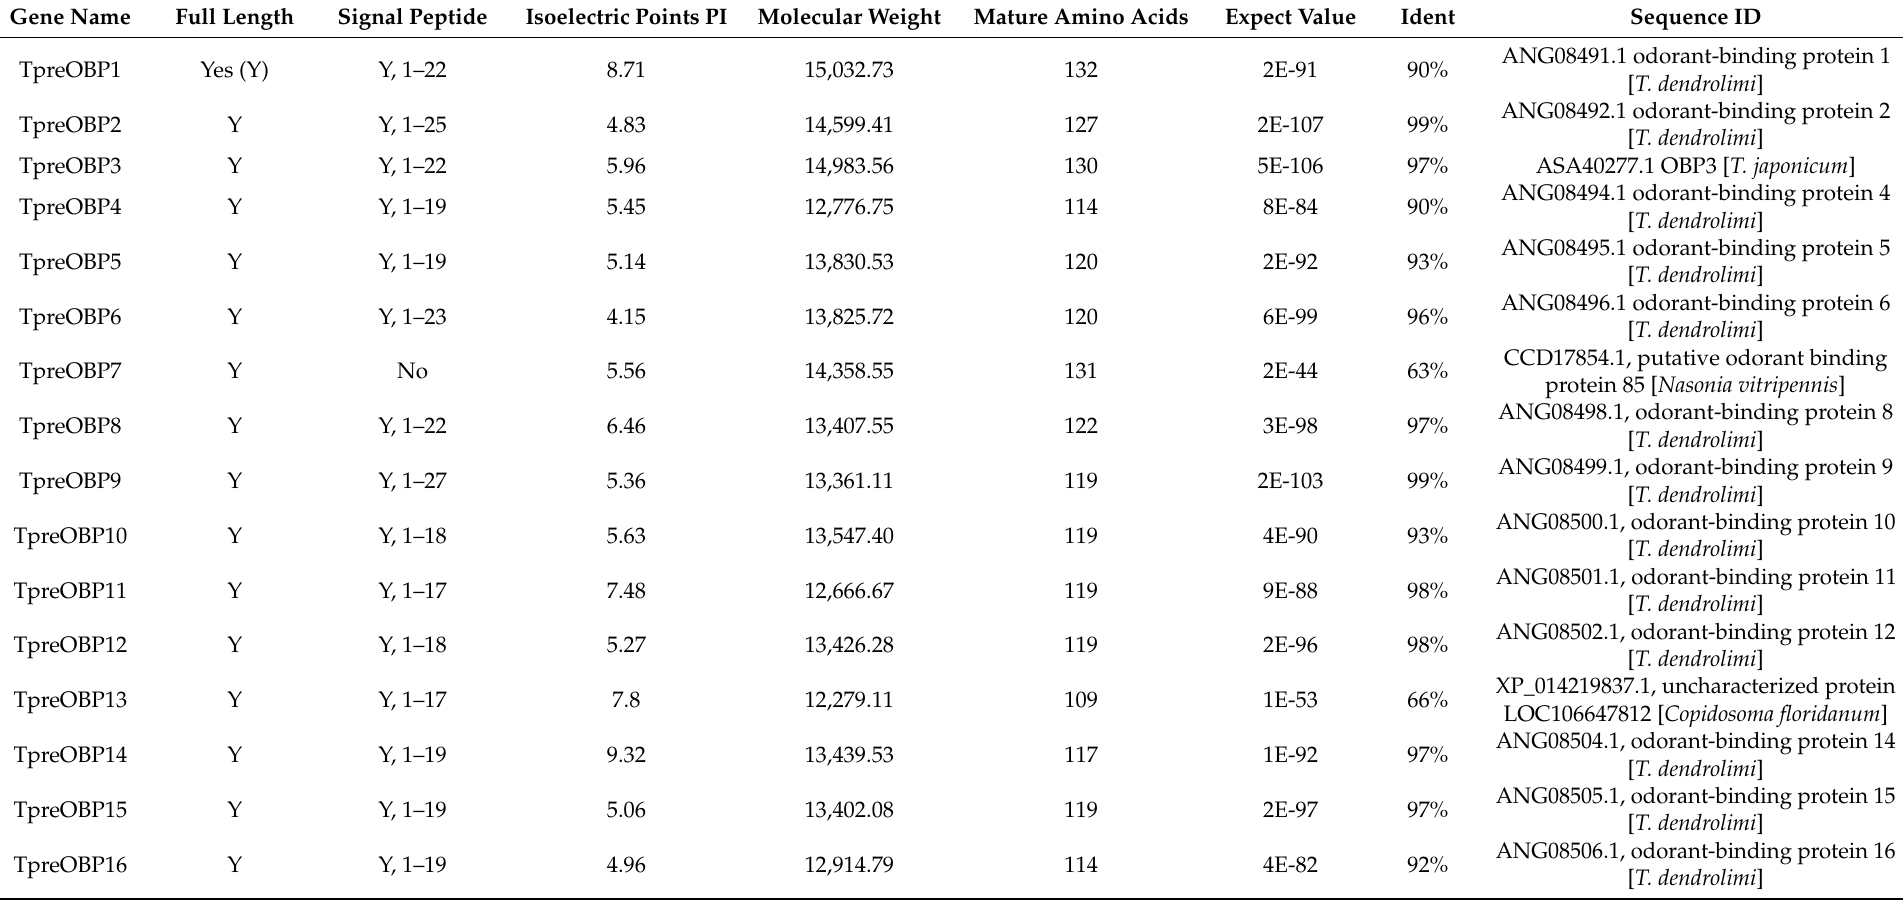
Table 2. T. pretiosum